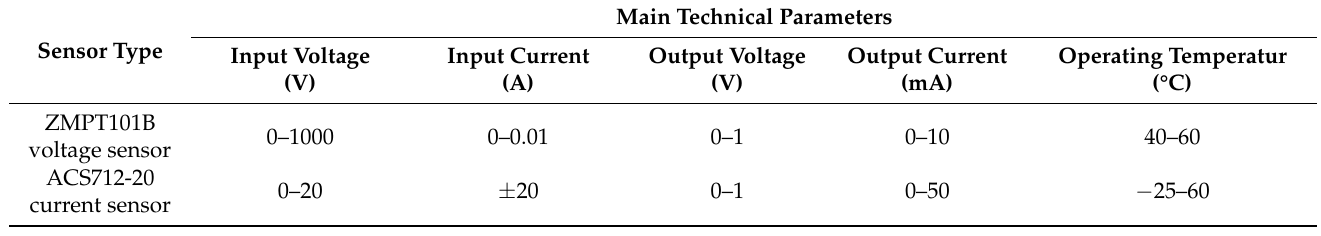
Table 2. Main technical parameters of voltage and current sensors.